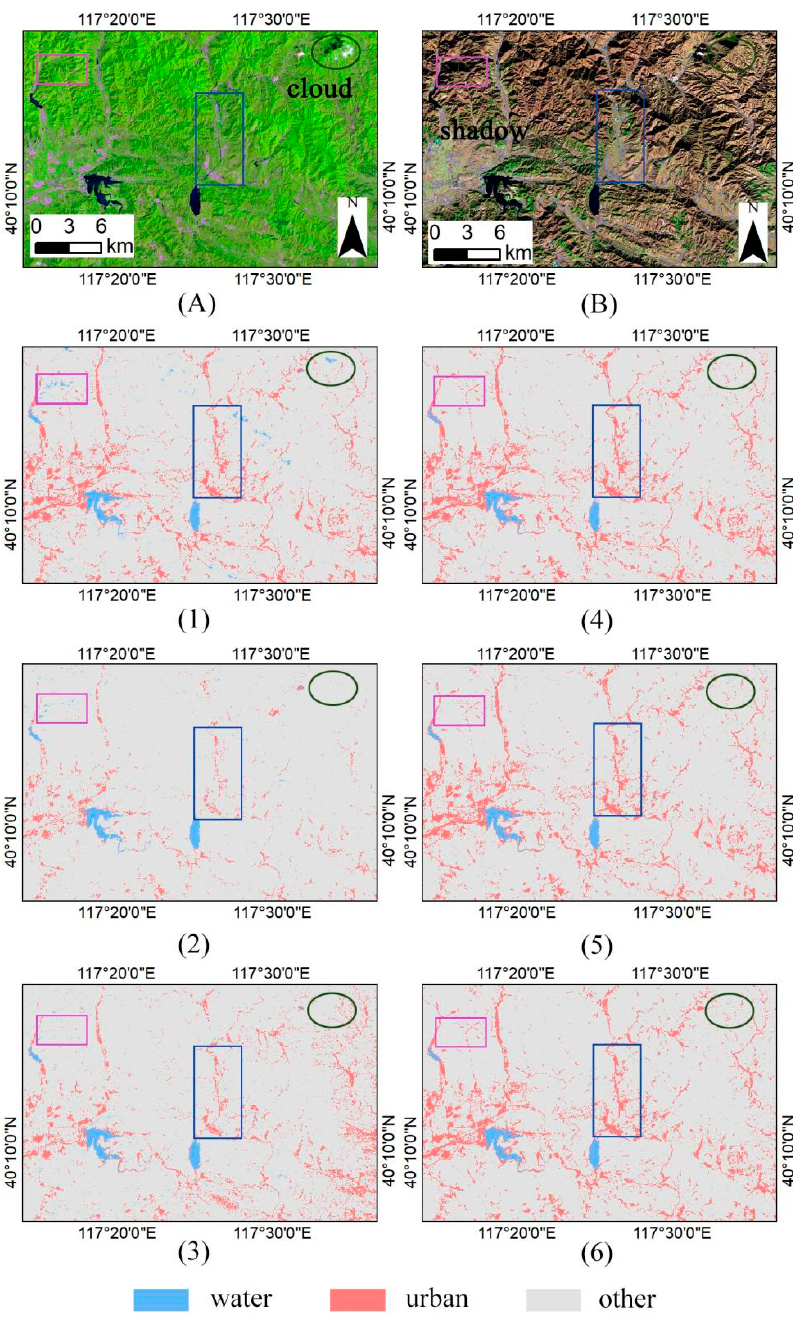
Figure 11. Performance comparisons in the representative places. (( A ) and ( B ) represent the Land- sat 8 data (R: Band 6; G: Band 5; B: Band 4, A is in summer, and B is in winter); (1)–(6) represent the schemes in Table 3; Table 5).